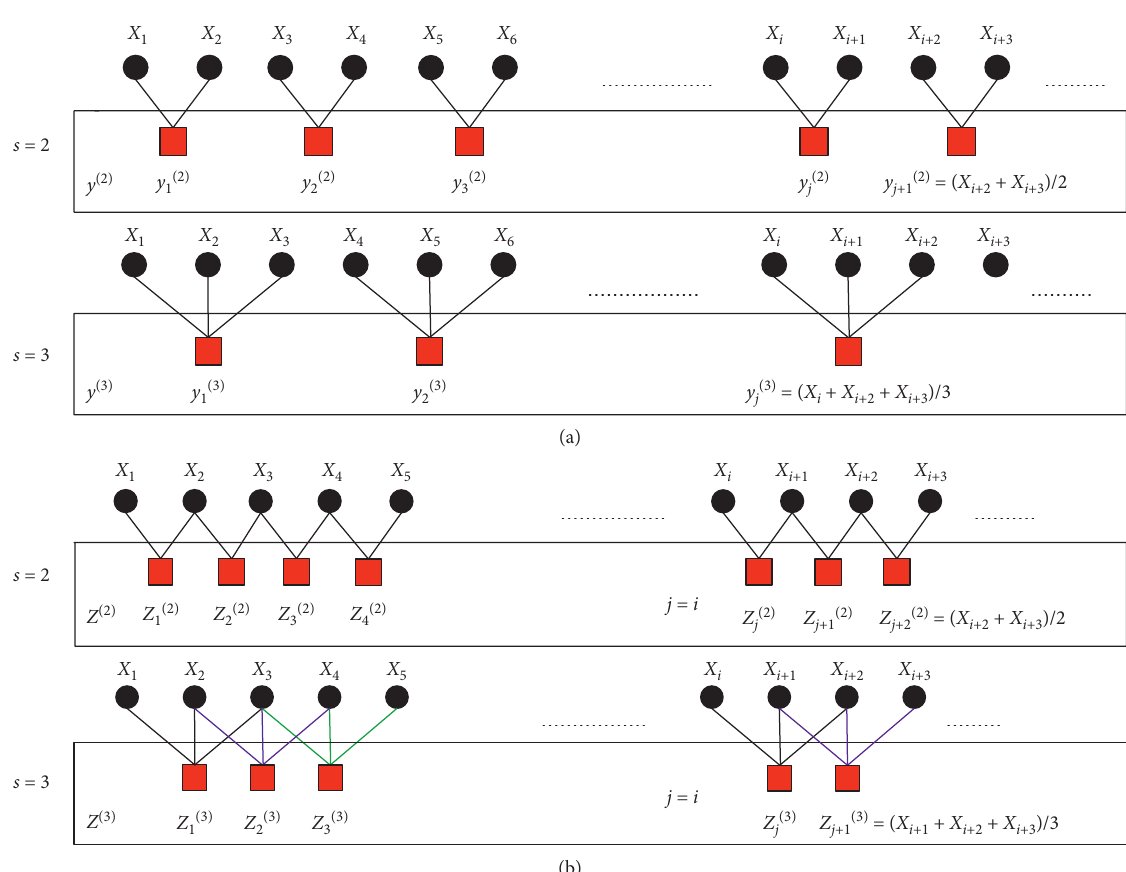
Figure 1: Improvement of coarse-graining. (a) Illustration of coarse-grained time series. (b) An improved illustration of coarse-graining time